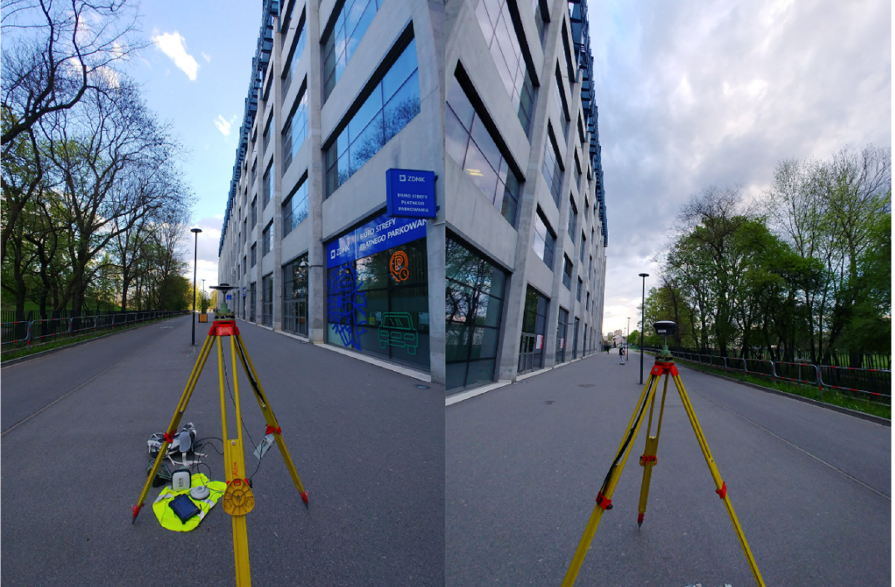
Figure 12. Field conditions at the Pt 7 station.